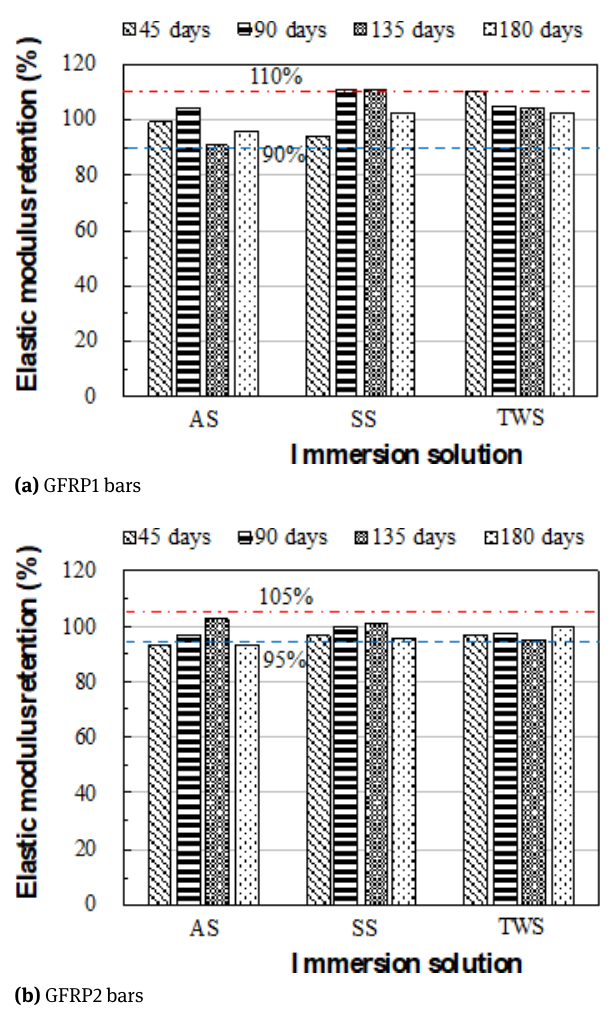
Figure 8: Elastic modulus retention of conditioned GFRP bars after different exposure